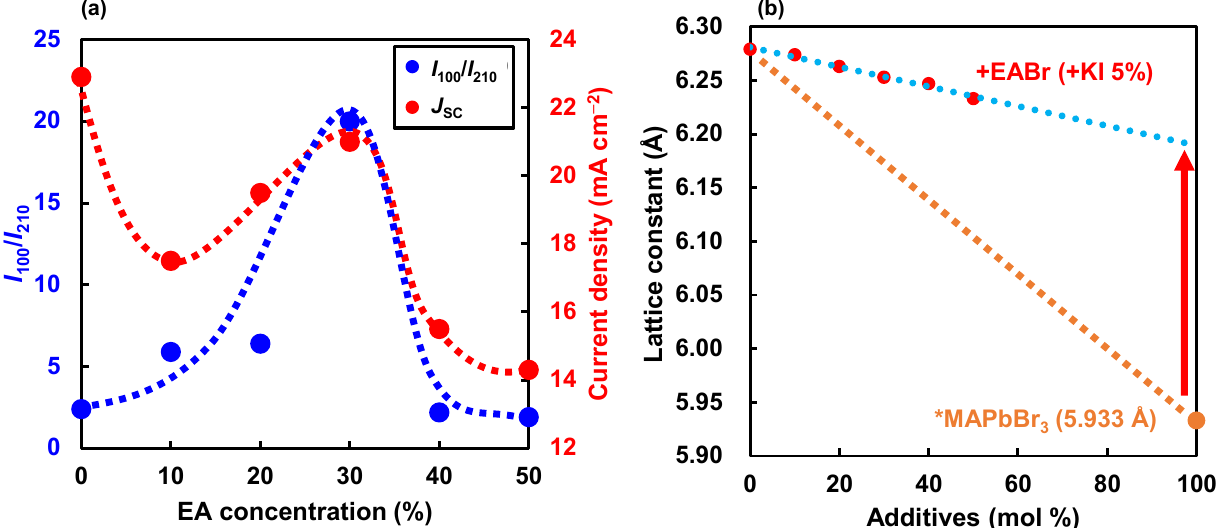
Figure 4. ( a ) Changes in the (100) orientation and short-circuit current densities, and ( b ) changes in lattice constants of the perovskites as a function of EA or Br concentration.